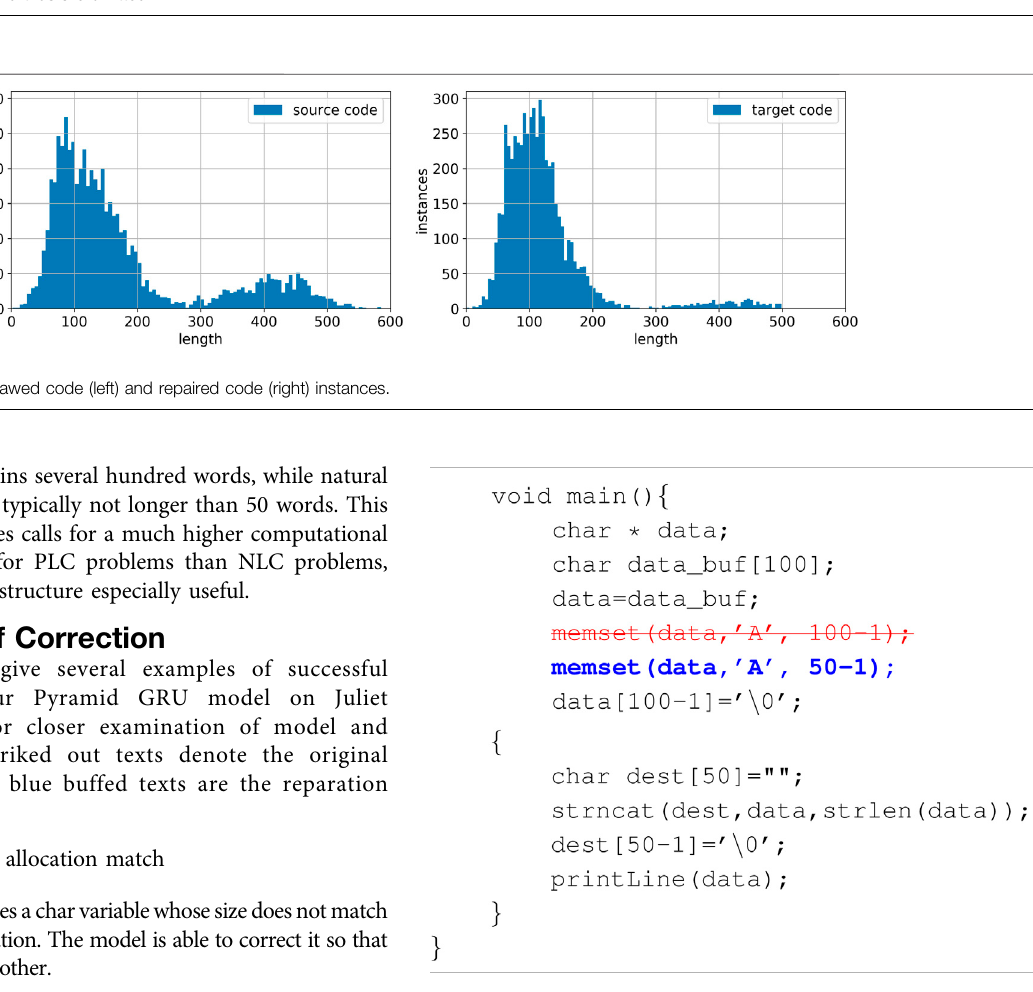
FIGURE 6 | Length analyses of Luong ’ s general attention and Luong ’ s concat attention. The results from the rest of the models are qualitatively similar to result of Luong ’ s general attention and thus are omitted.